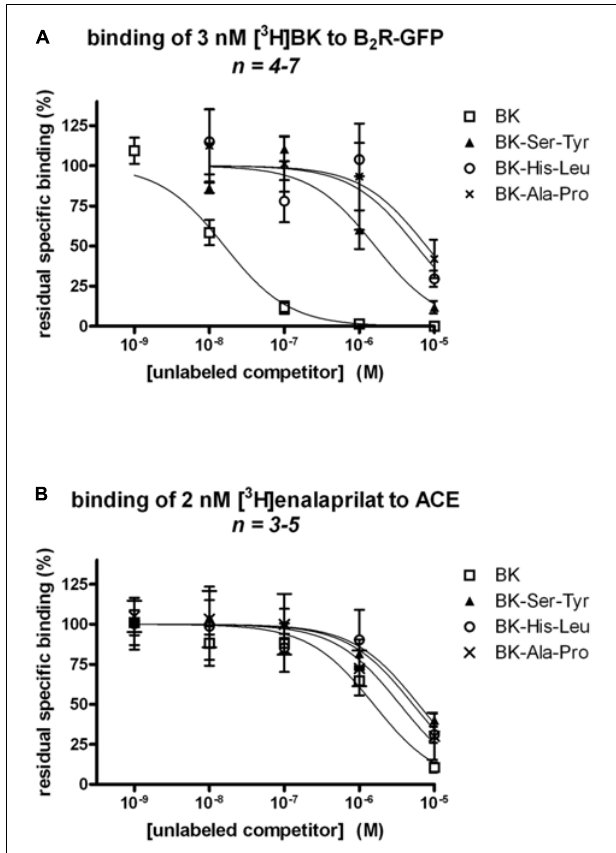
FIGURE 2 | Competition of the binding of two radioligands at their respective recombinant molecular target by BK or three C-terminally extended analogs developed as potentialACE substrates. (A) Competition of [ 3 H]BK (3 nM) binding to stably expressed B 2 R-GFP in HEK 293 cells. (B) Competition of [ 3 H]enalaprilat (2 nM) binding to transiently expressed human somatic ACE. Results are expressed as the residual specific bindings (means ± SE of n duplicate determinations).